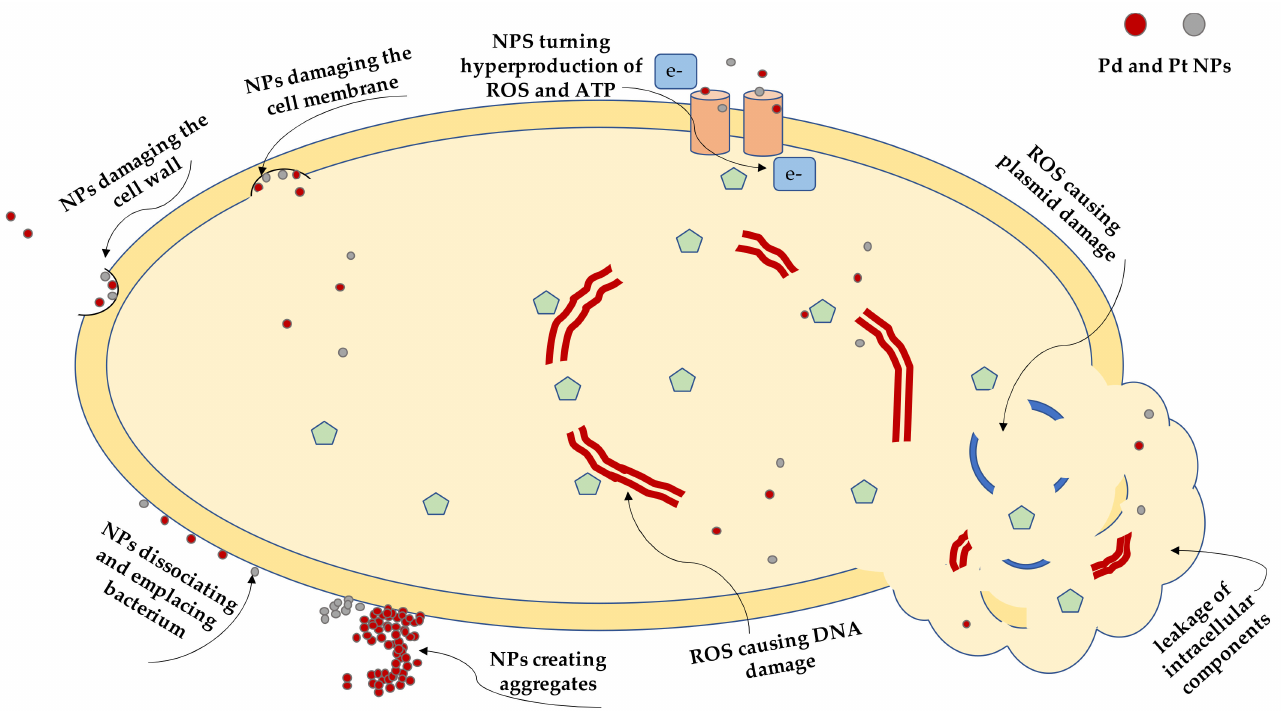
Figure 1. A schematic illustration of possible mechanism of action of palladium nanoparticles (PdNPs) and platinum nanoparticles (PtNPs) on a bacterial cell and its